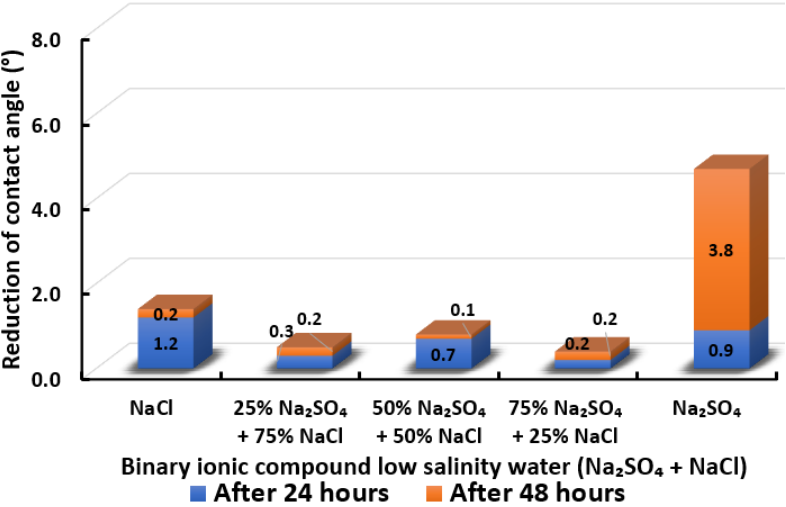
Figure 20. Contact angle reduction results for binary ionic compounds smart water (SW) solutions Na 2 SO 4 + NaCl (3500